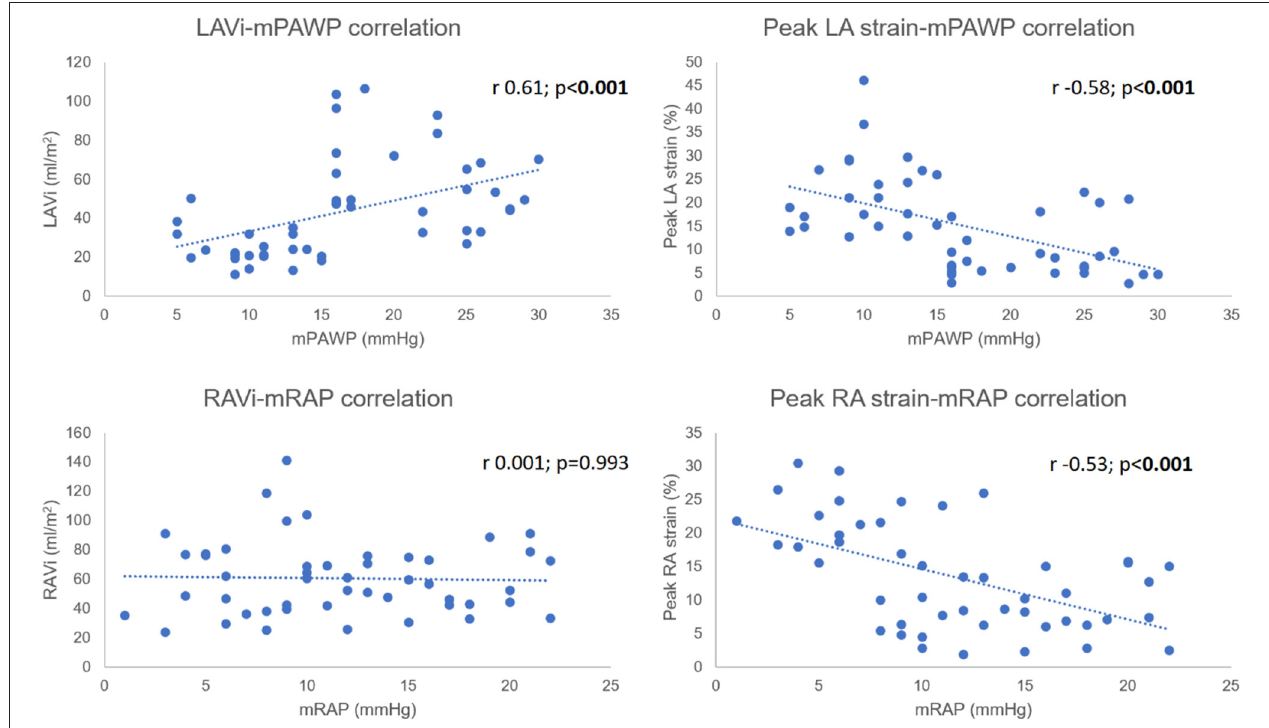
FIGURE 4 | Biatrial pressure-volumetric/strain correlation in entire cohort.